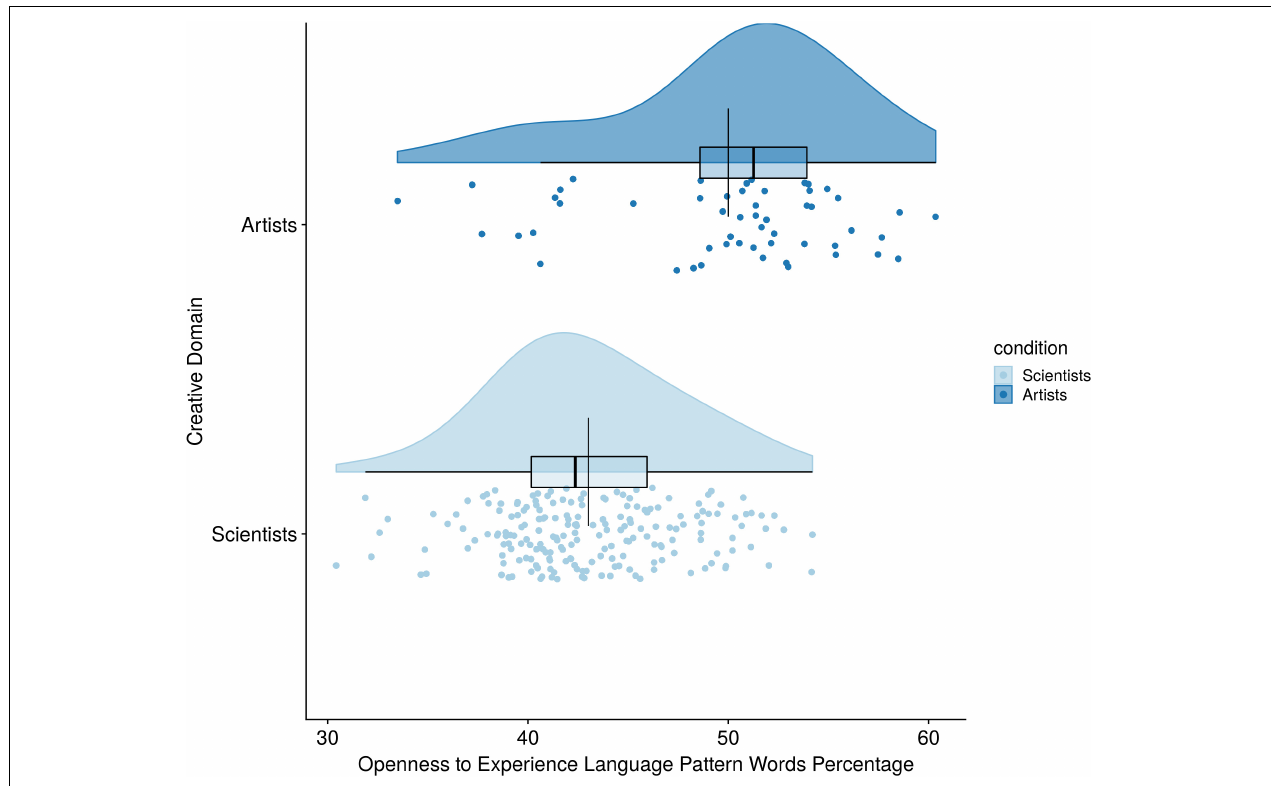
FIGURE 6 | Creative domain differences on openness to experience language pattern